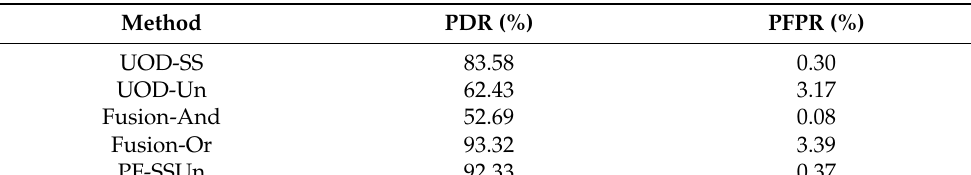
Table 2. Comparison of performance indicators between independent method before fusion and different fusion strategies.